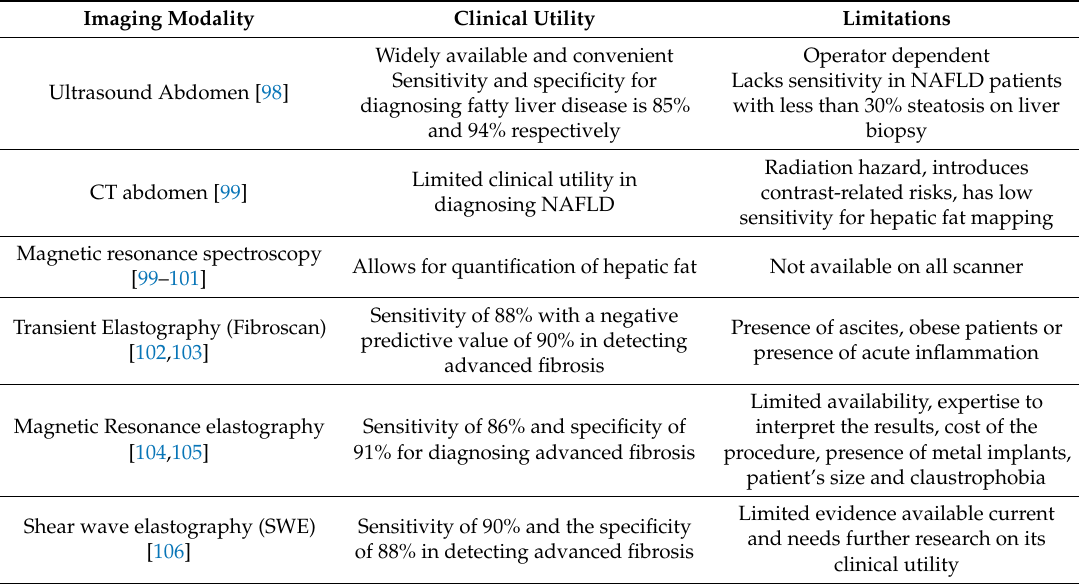
Table 7. Imaging modalities for the diagnosis of